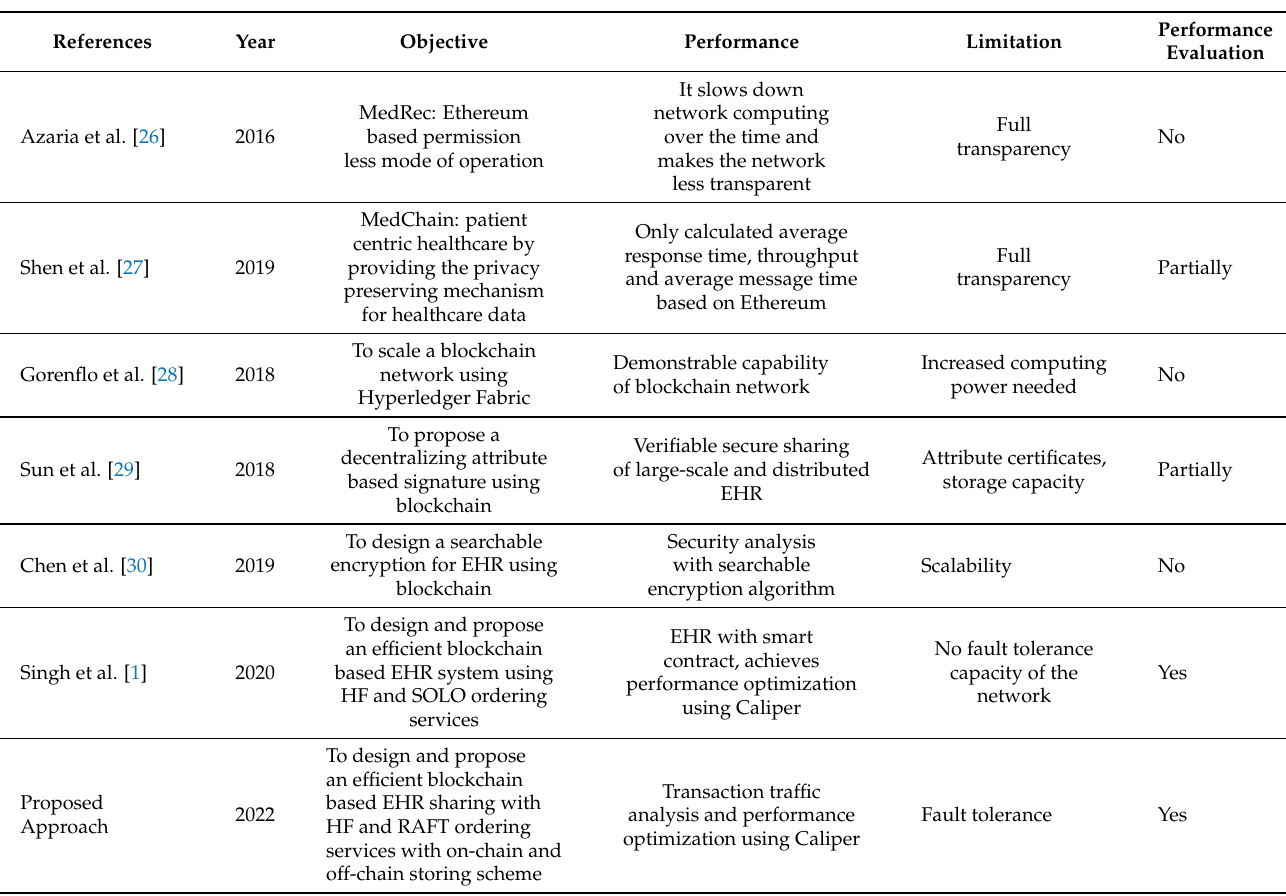
Table 1. Related work on blockchain-based approaches for the EHR system.